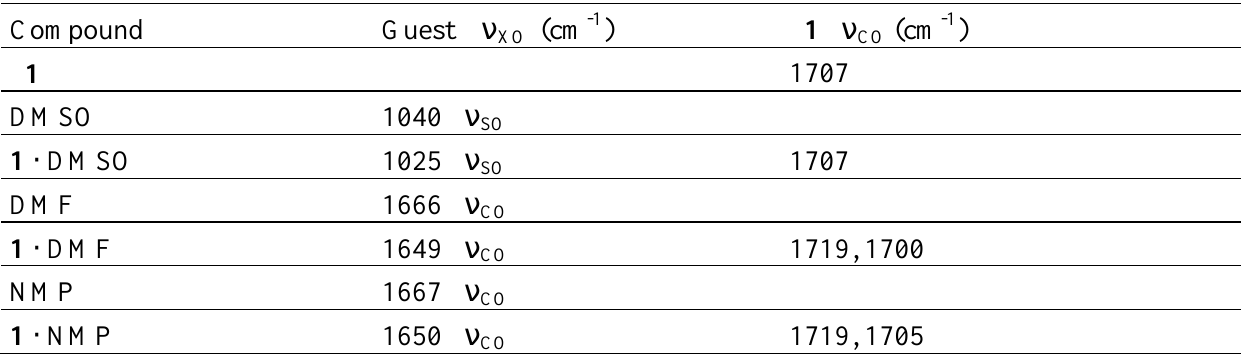
Table 2 . Assignment and wavenumbers of the vibrational bands (KBr) of free dehydrocholic acid 1 , DMSO, DMF, NMP and the related inclusion compounds.